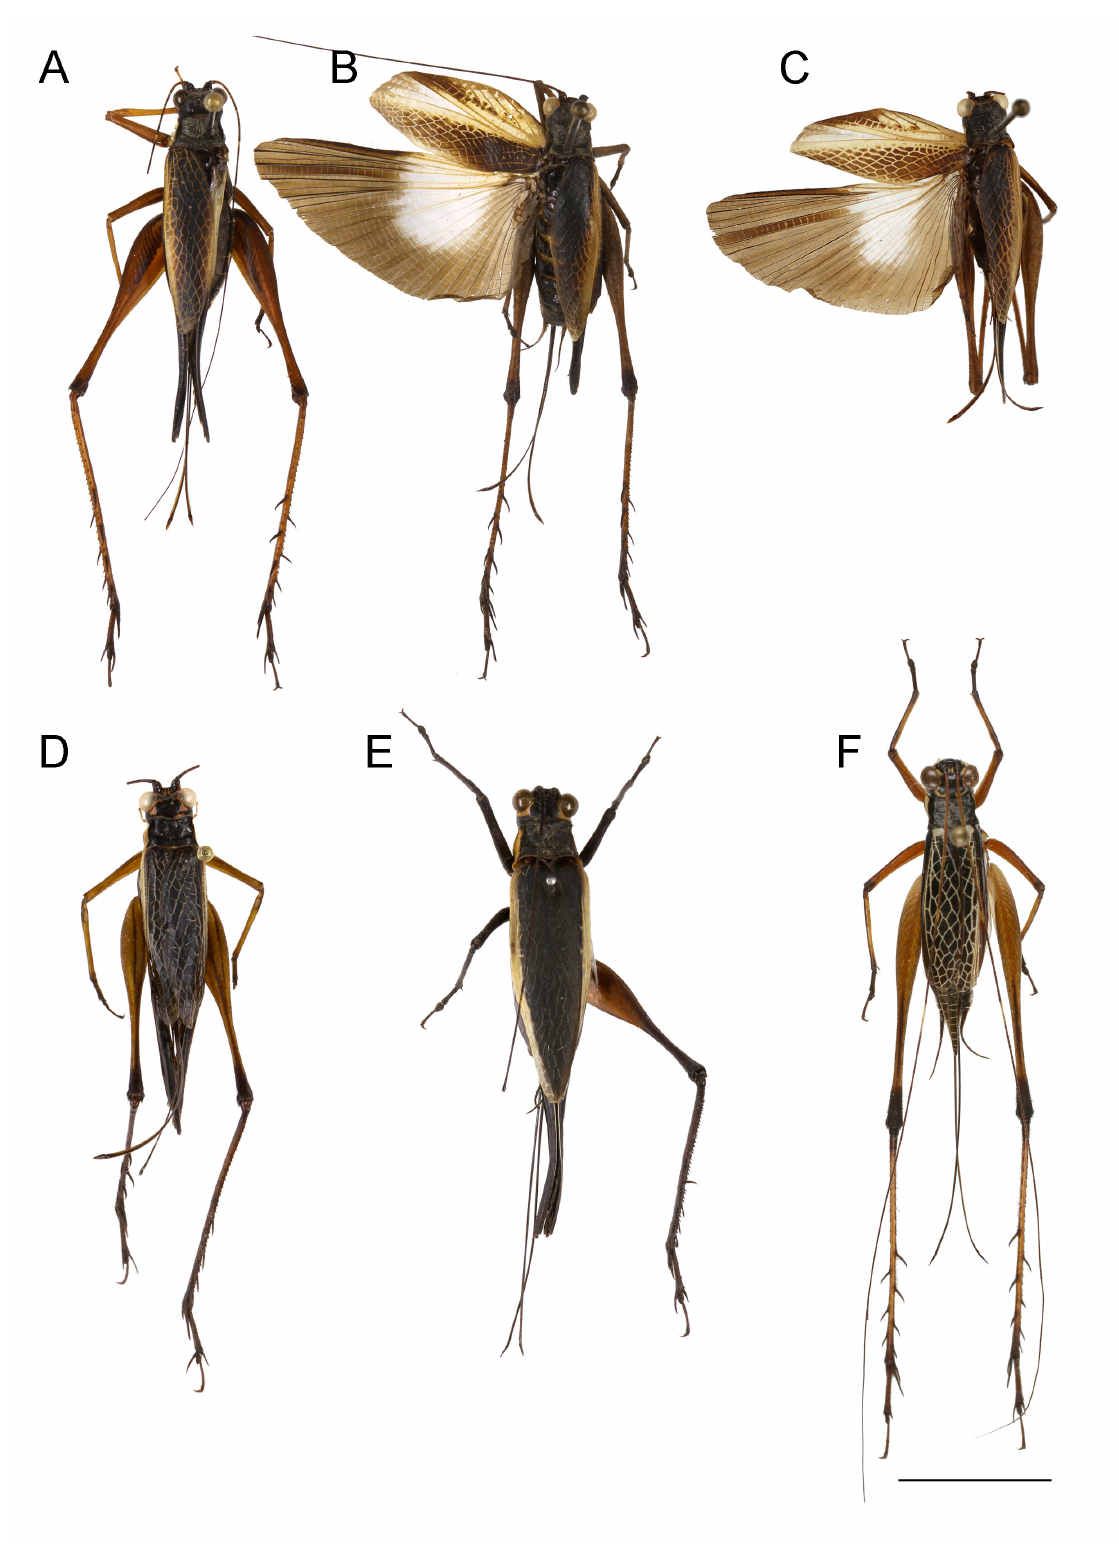
Fig. 8. Habitus of ♀♀ in dorsal view. A–B . Nisitrus brunnerianus Saussure, 1878. C . N. crucius Robillard & Tan sp. nov. D . N. danum Robillard & Tan sp. nov. E . N. hughtani Robillard & Tan sp. nov. F . N. insignis Saussure, 1878. Scale bar = 10